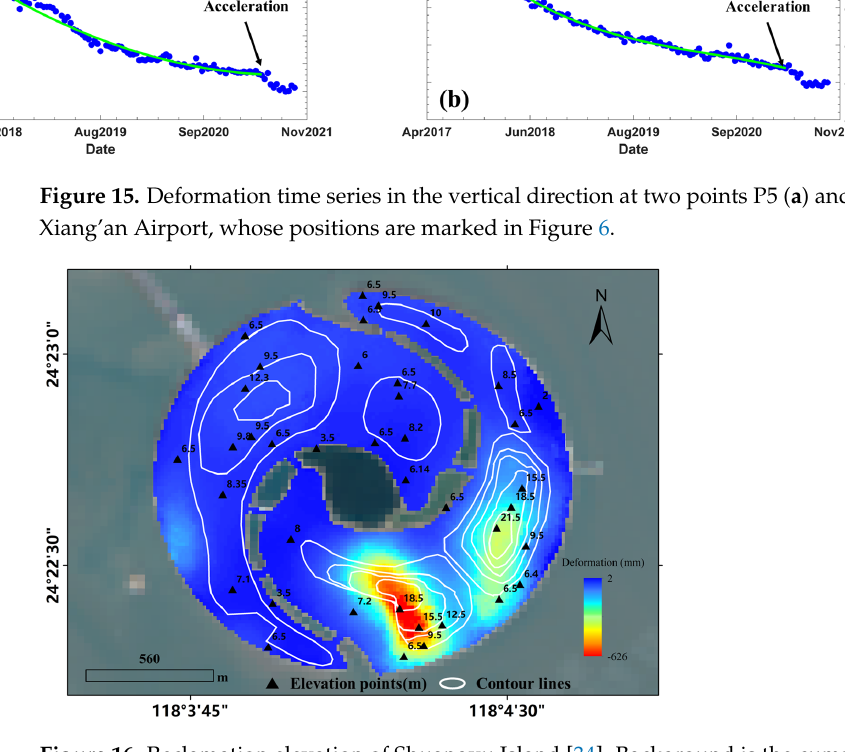
Figure 16. Reclamation elevation of Shuangyu Island [34]. Background is the cumulative subsidence of Shuangyu Island.